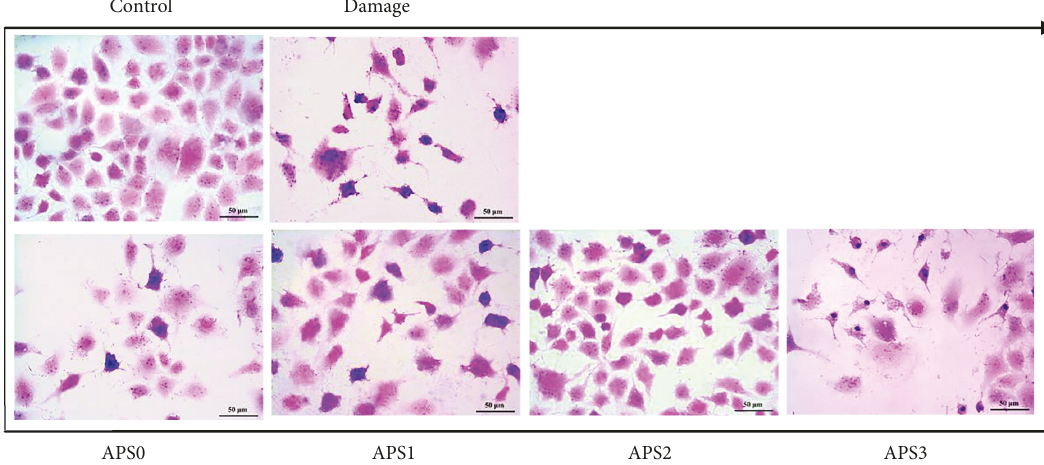
Figure 9: Morphological changes after the damaged HK-2 cells were repaired by APS with di ff erent molecular weights. Oxalic acid concentration: 2.6 mmol/L, injury time: 3.5h; polysaccharide concentration: 60 μ g/mL, repair time: 10h.